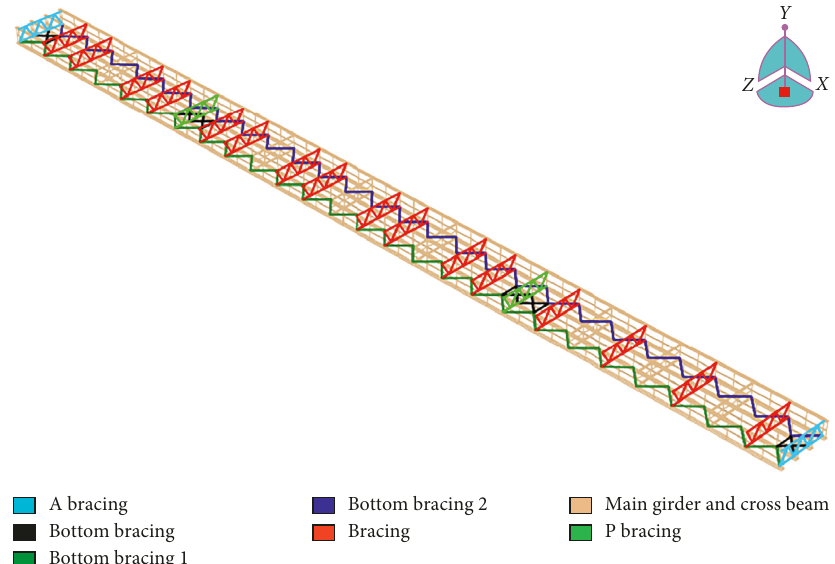
Figure 28: Locations of